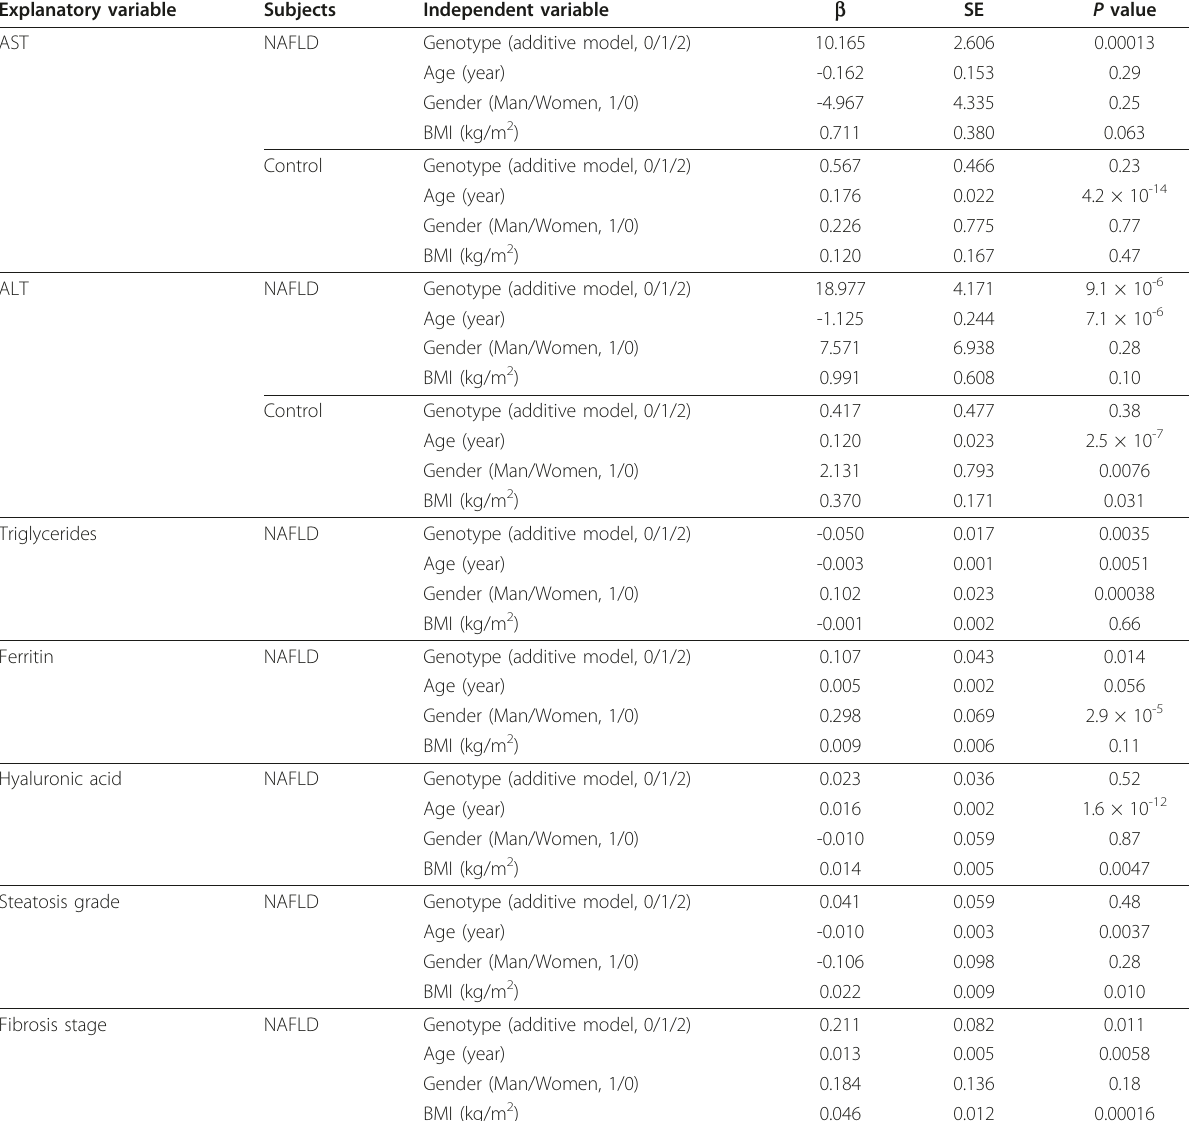
Table 5 Multiple linear regression analysis for AST, ALT, triglycerides, ferritin, hyaluronic acid, steatosis grade, and fibrosis stage Explanatory